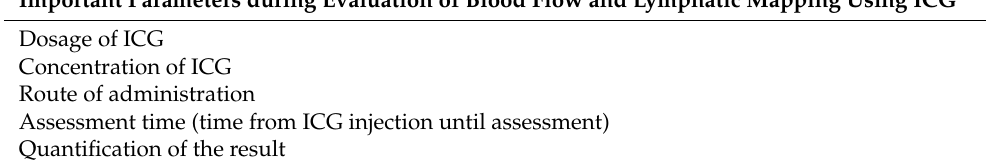
Table 2. Important parameters during evaluation of blood flow and lymphatic mapping using ICG. Important Parameters during Evaluation of Blood Flow and Lymphatic Mapping Using